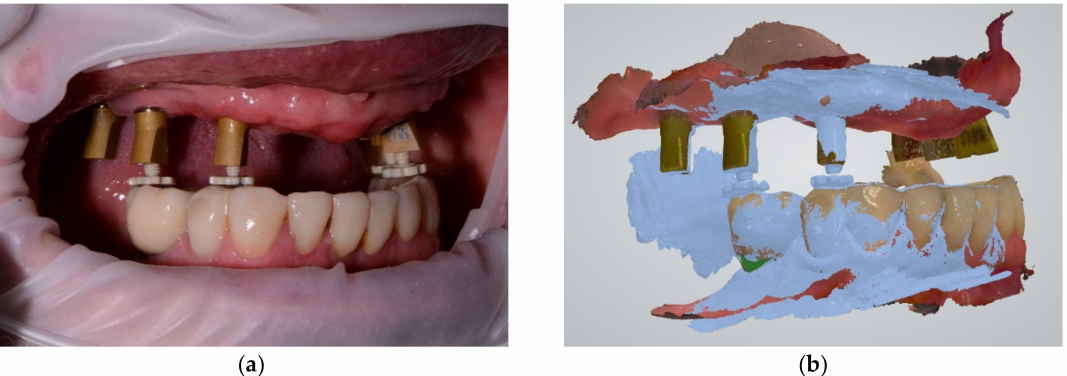
Figure 9. ( a ) Right lateral side with a stable contact on four bite pillars screwed into the scan parts of the dual-function scan bodies at the desired OVD. ( b ) View on screen after digital bite registration at the right lateral side (3Shape Dental Desktop 1.7.9.1, 3Shape, Copenhagen,